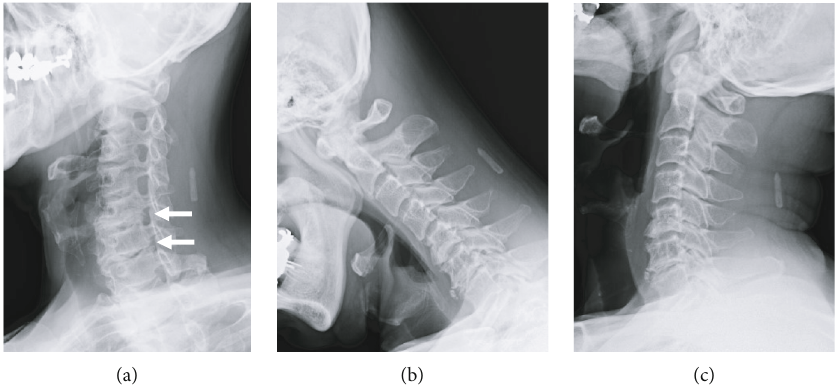
Figure 1: Cervical spine X-ray images. The left oblique view (a) revealed the left C5-6 and C6-7 stenoses (arrow). Ante fl exion (b) and retro fl exion (c) did not show cervical spine